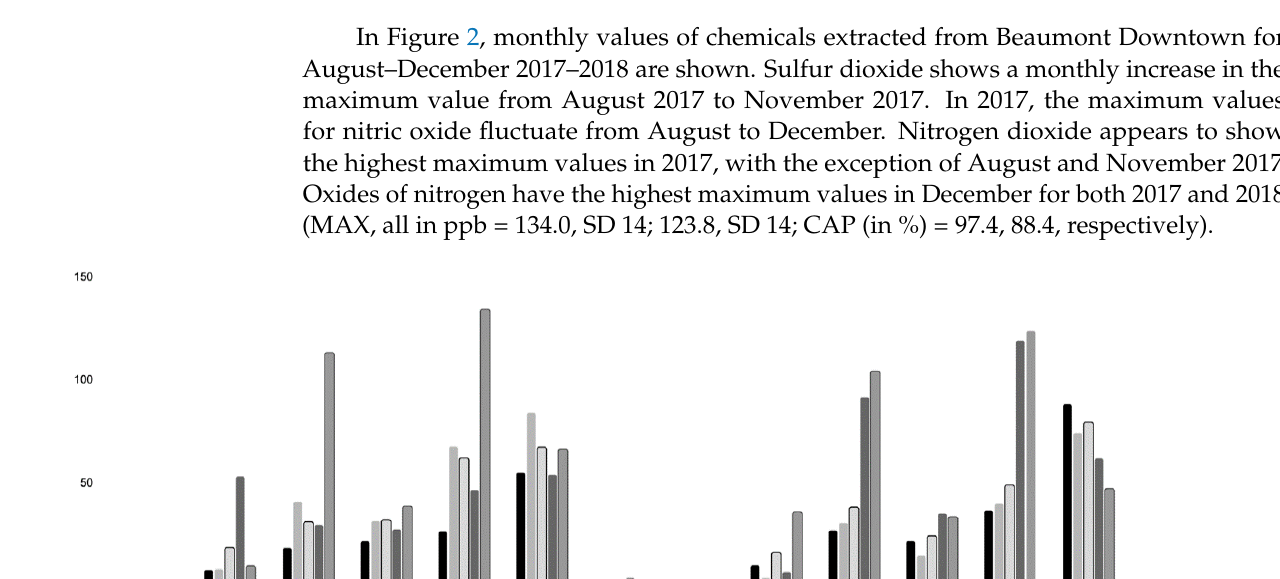
Figure 2. Beaumont Downtown Air Monitor Monthly Maximum Values in PPB For Air Pollutants,